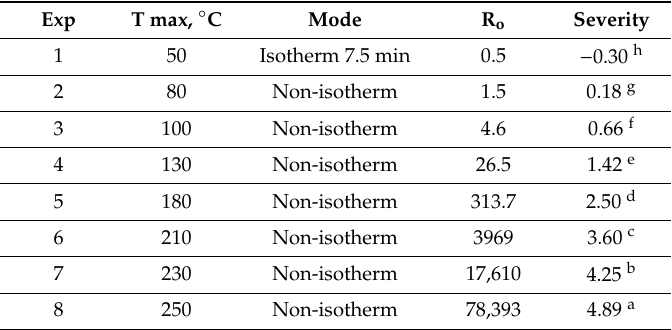
Table 2. Reaction ordinate (R o ) and severity for each experiment, calculated between the initial and final temperatures of 30 ◦ C.